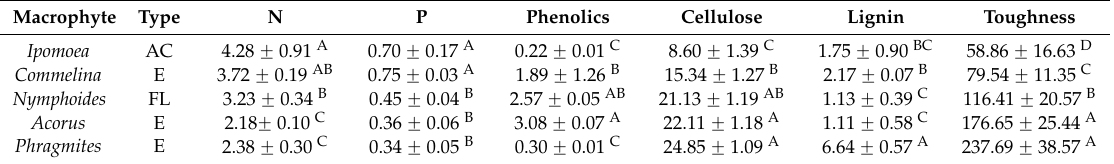
Table 1. Physical and chemical characteristics of the five study macrophyte